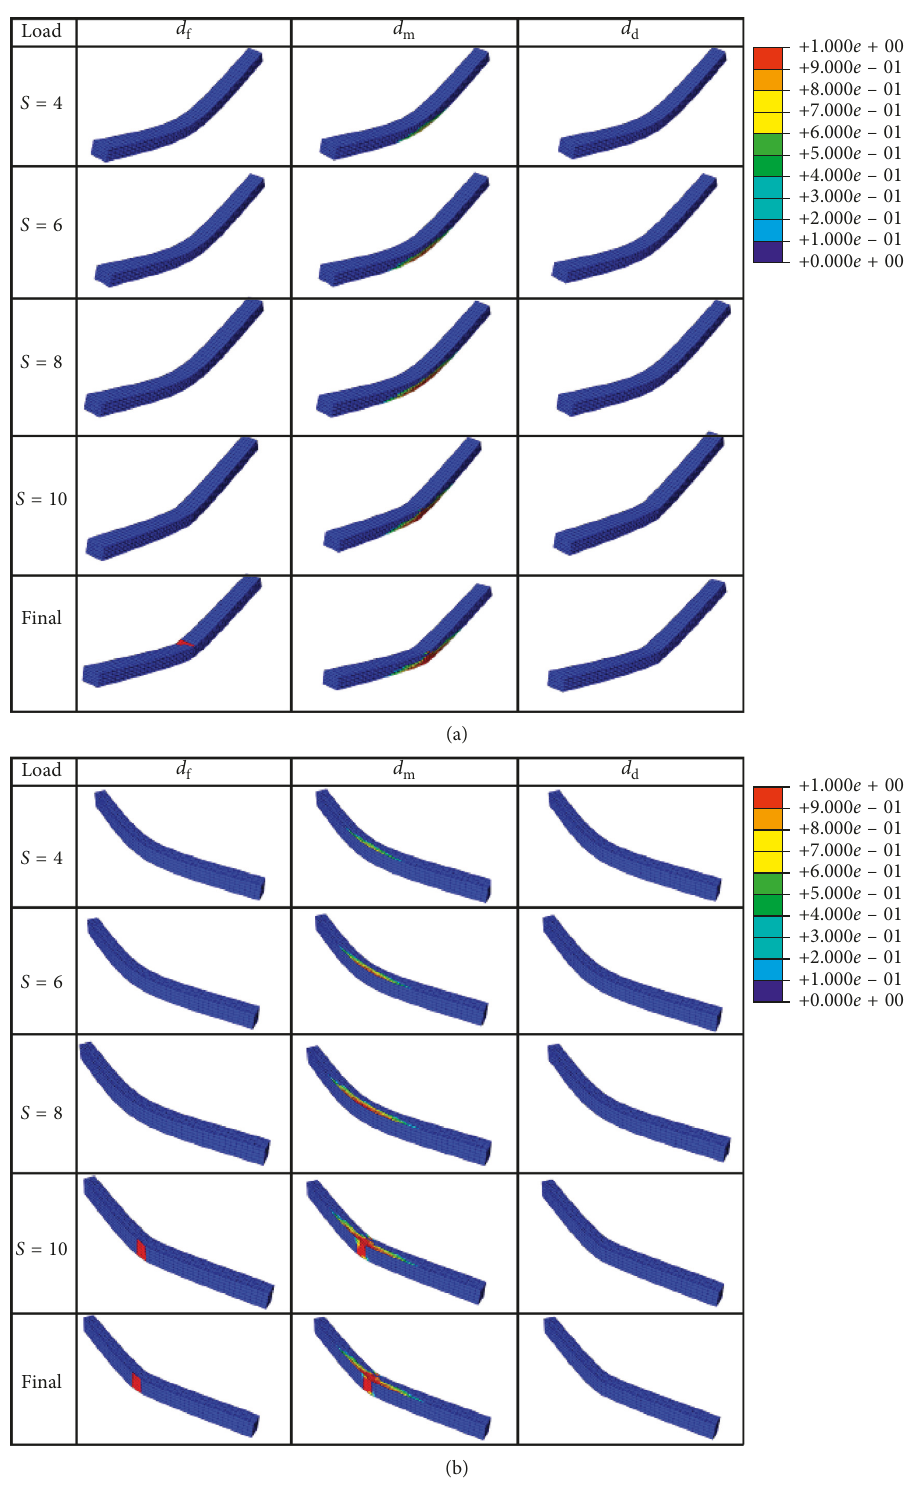
Figure 10: Failure modes of transverse specimens. (a) Top surface. (b) Bottom